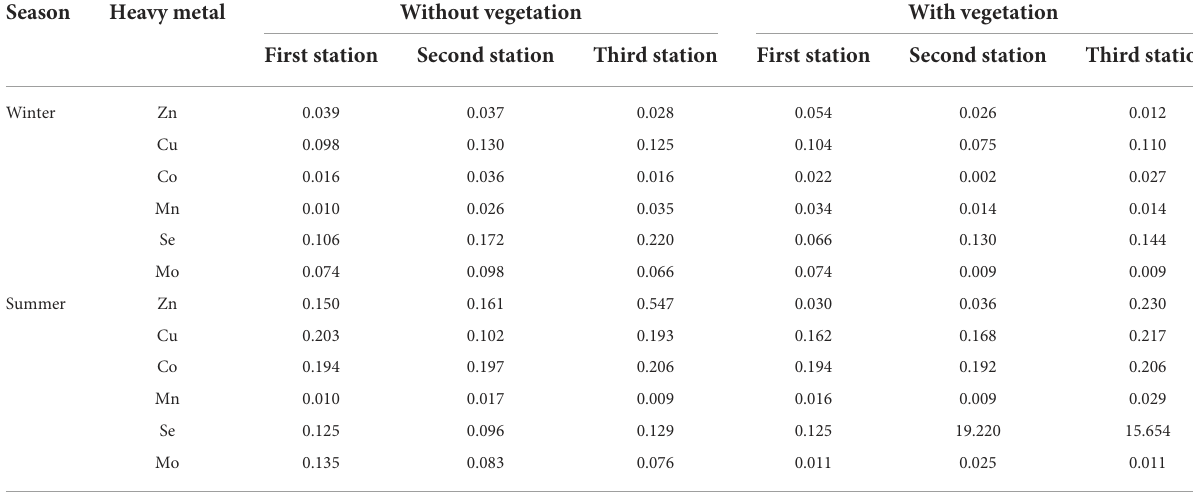
TABLE 8 Values of enrichment factor for heavy metals in the soils of Shadegan wetland (winter and summer in 2019). Season Heavy